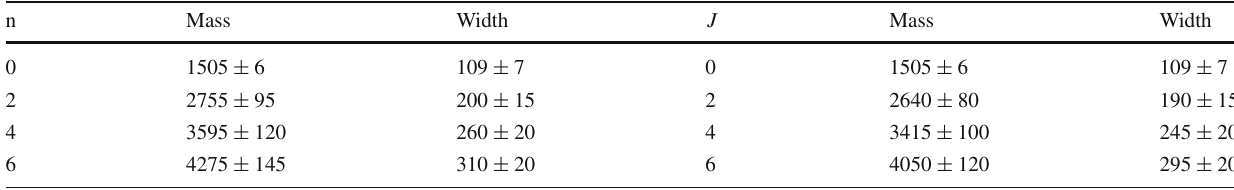
Table 8 Predictions using linear trajectories with glueball slope using f 0 ( 1500 ) as the ground state n